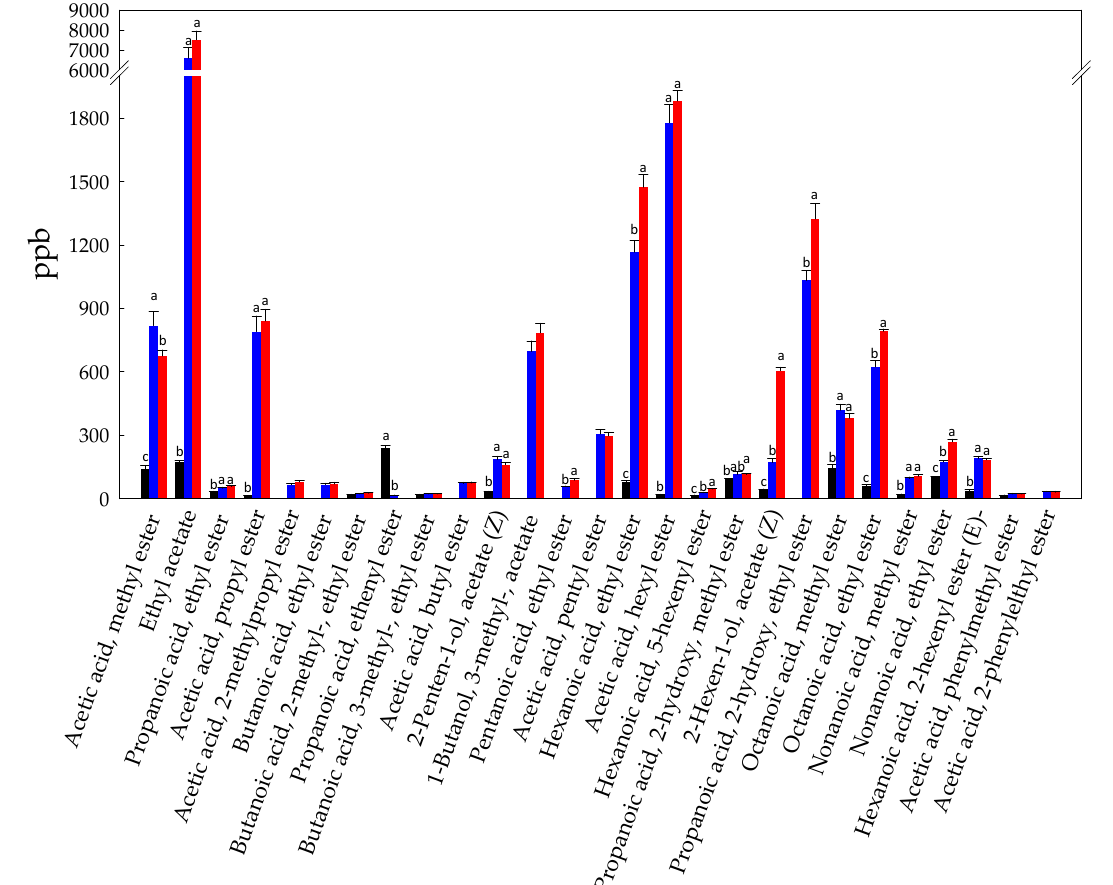
Figure 5. Concentration (ppb) of esters identified in Raw- (black bars), Unstarted- (blue bars), and Started-BCP (red bars). Data are the means ( ± SD) of three independent experiments analyzed in triplicate. Data were subjected to one-way ANOVA; pair-comparisons of treatment means was achieved by Tukey’s procedure at p < 0.05. For each compound, bars with different superscript letters differ significantly ( p < 0.05).